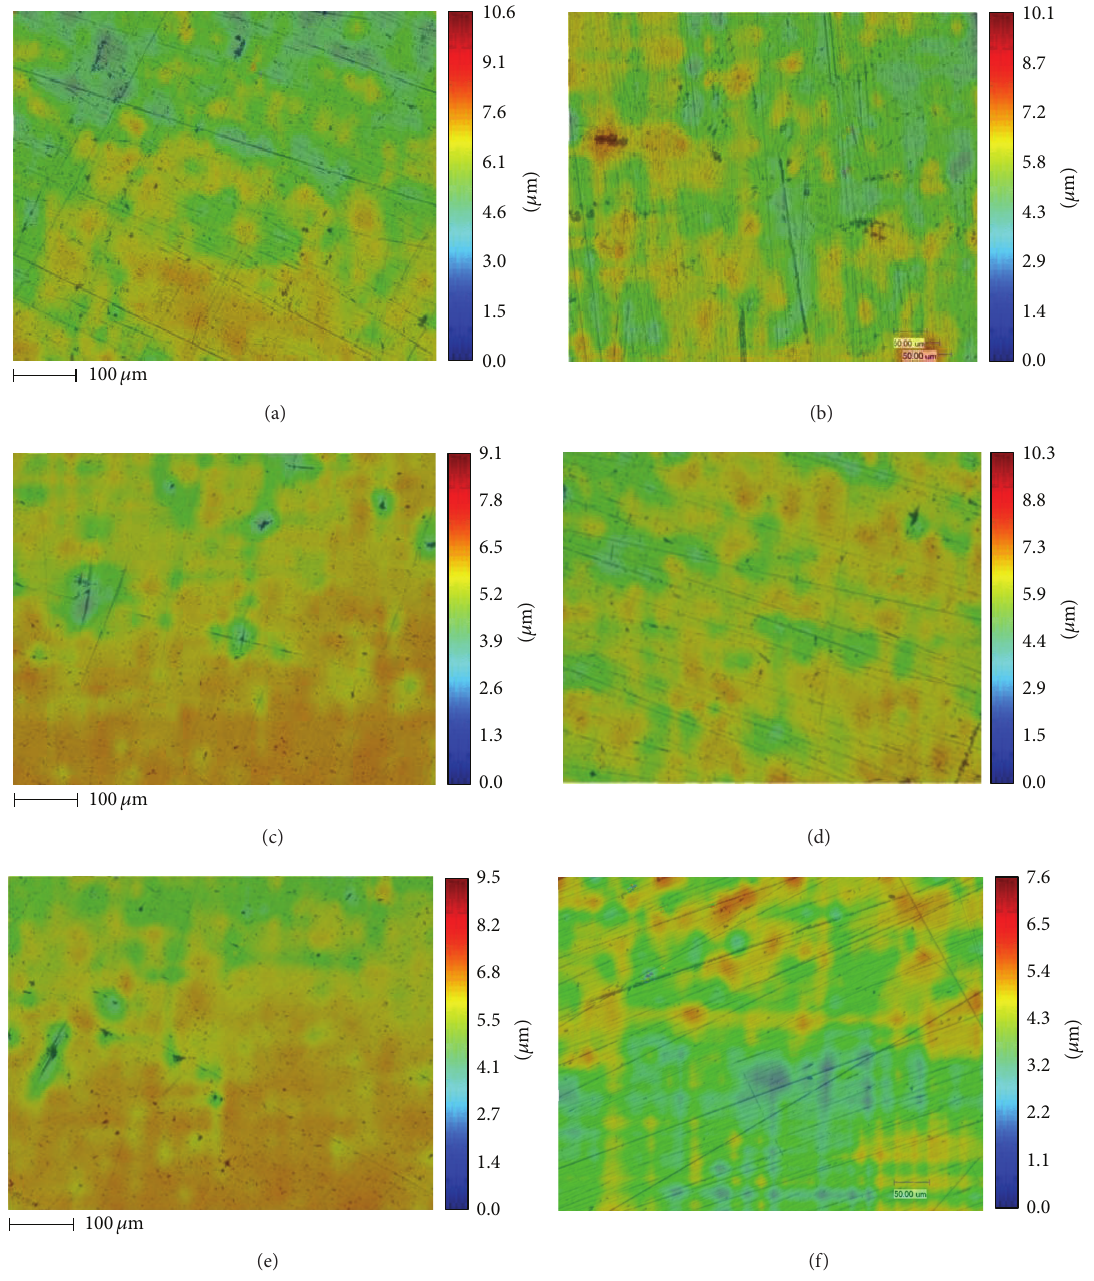
Figure 17: Depth cloud map of 17-4PH specimens impacted by high speed water droplets: (a) case 1, (b) case 2, (c) case 3, (d) case 4, (e) case 5, and (f) case